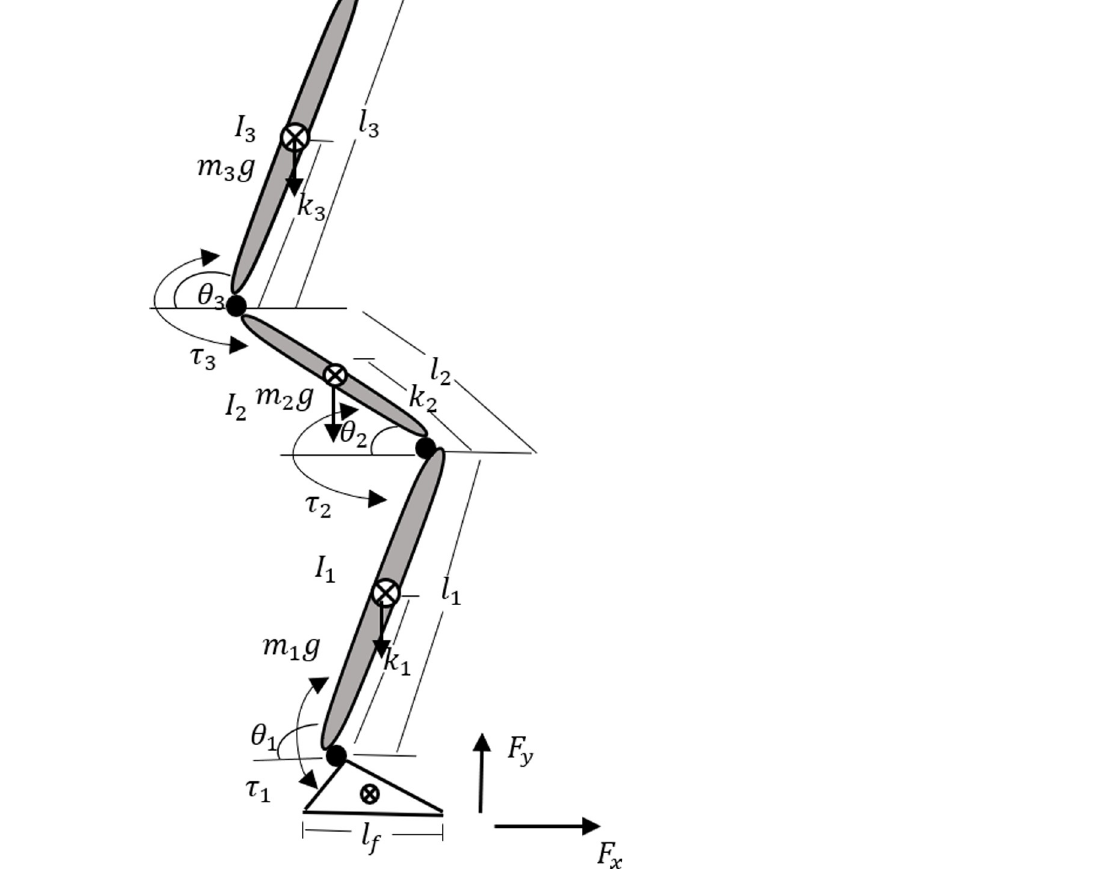
Fig 1. The layout of the 4-segments biomechanical model in the sagittal